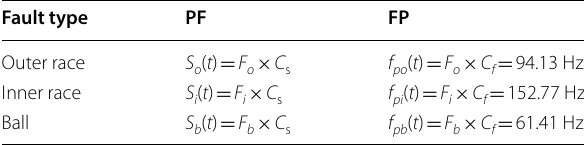
Table 4 PFs and FPs under inner race